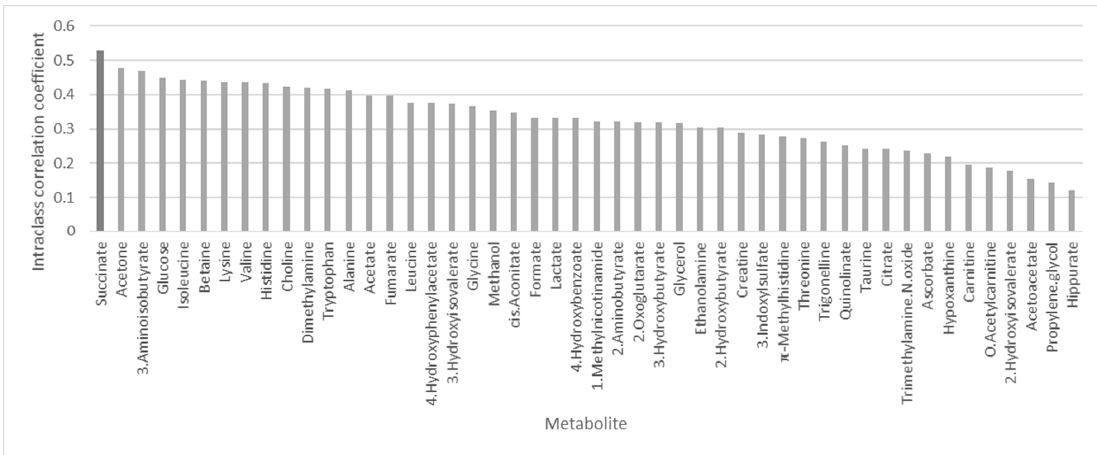
Figure 1. Intraclass correlation coefficient (ICC) for each metabolite ordered from the largest (succinate) to the smallest ICC (hippurate). ICC estimates of the proportion of the total variability that is due to between-subject variability. An ICC above 0.5 (bold line) indicates higher similarity between measurements across children. ICC values below 0.5 (grey line) indicate higher similarity for the measurements within children. Most metabolites have higher variation within children than across children.